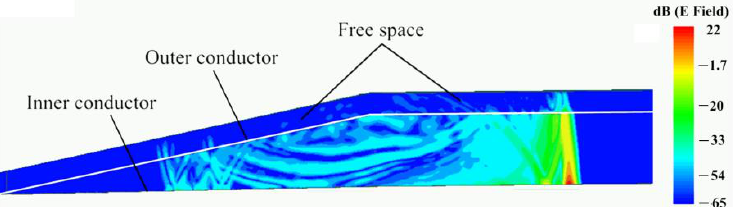
Figure 6. Detailed numerically simulated pattern of the distribution of the modulus of the electric field in the case of propagation of a unipolar EMP with a duration of 200 ns FWHM in the coaxial line with the slit geometry of the outer conductor: longitudinal metal plates 7.5 cm wide are installed with gaps 5 cm wide. The time instant is 18 ns.